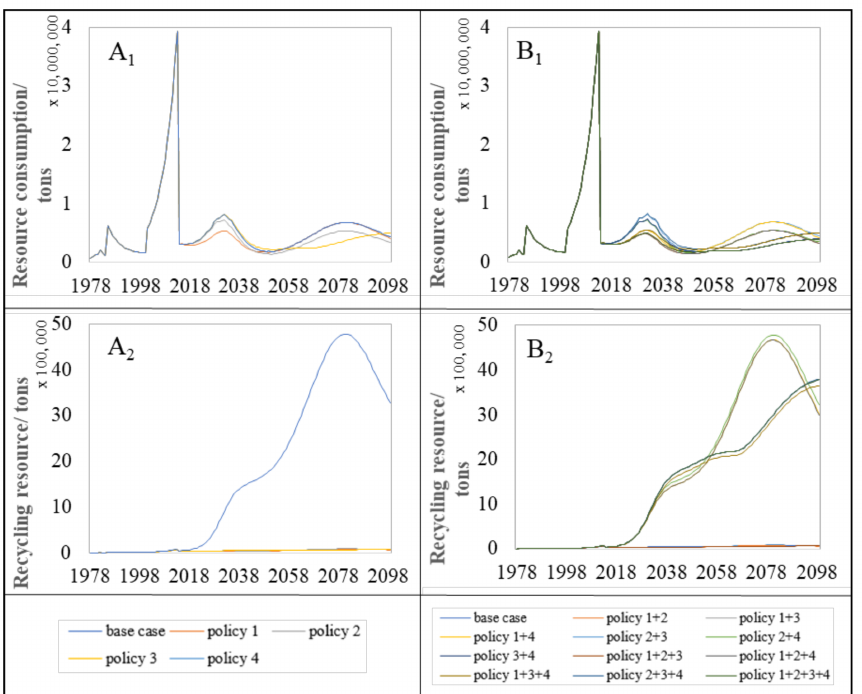
Figure 7. Annual resource impacts trends for base case and proposed policy measures. A 1 and B 1 represent the impact trend of single policy and complex policy on resource consumption, respectively. A 2 and B 2 are the impact trend of single policy and complex policy on recycling resource, respectively.